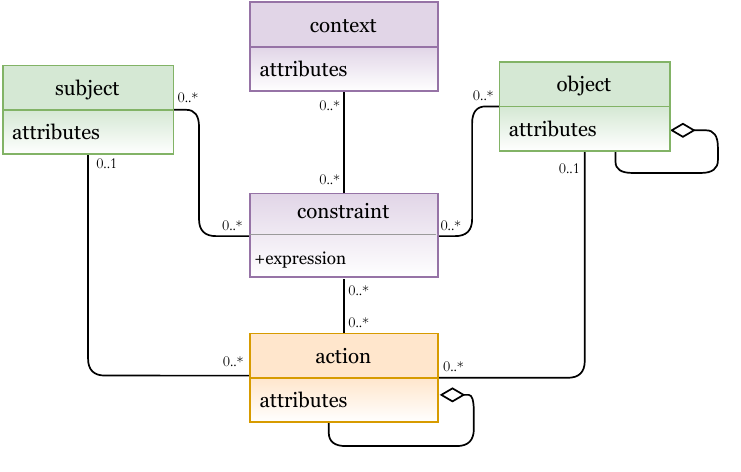
Figure 12. ABAC model instance.